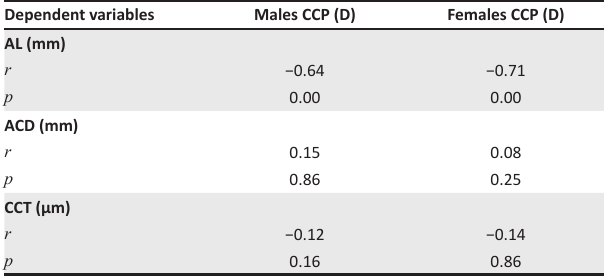
D, dioptre. FIGURE 3: A significant negative correlation between central corneal power and axial length in female students ( n = TABLE 4: Pearson’s correlations between central corneal power and some biometric variables in male and female participants. Dependent variables dioptre; s.d., standard deviation.